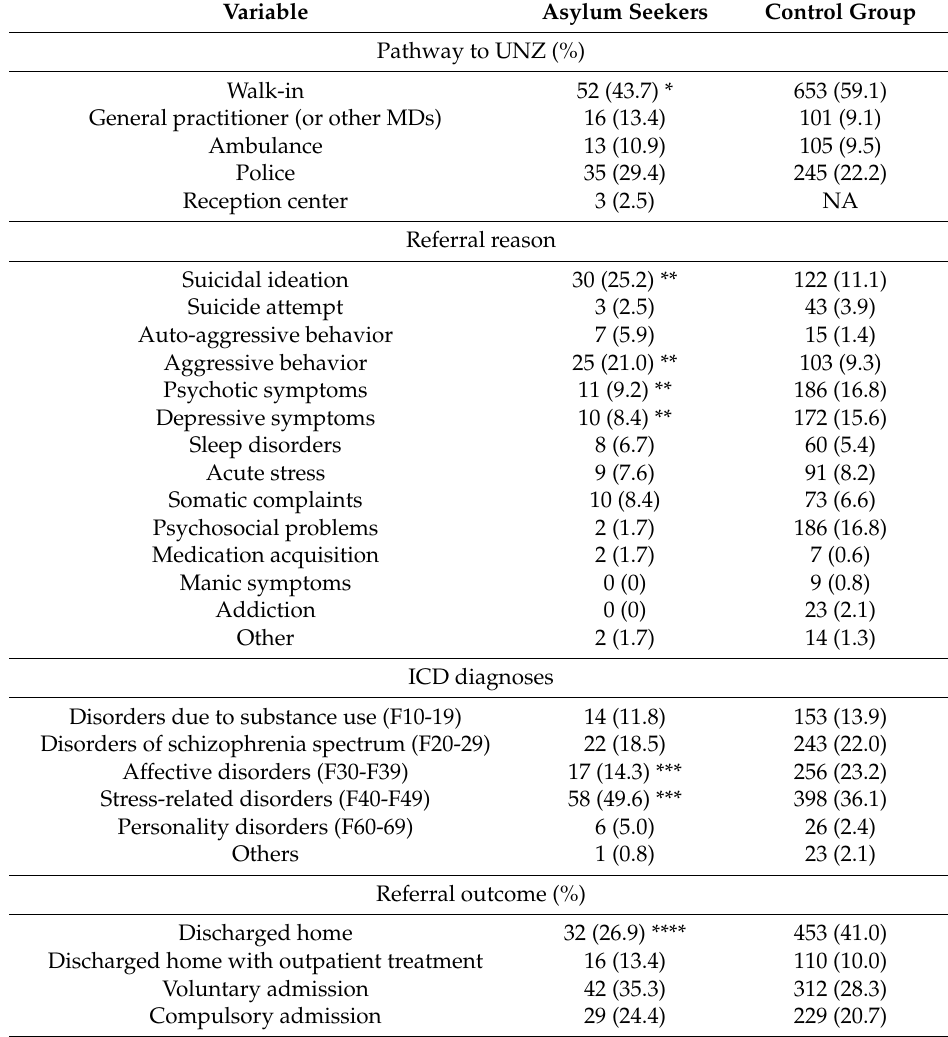
Table 3. Clinical characteristics of asylum seekers ( n = 119) and control group ( n =